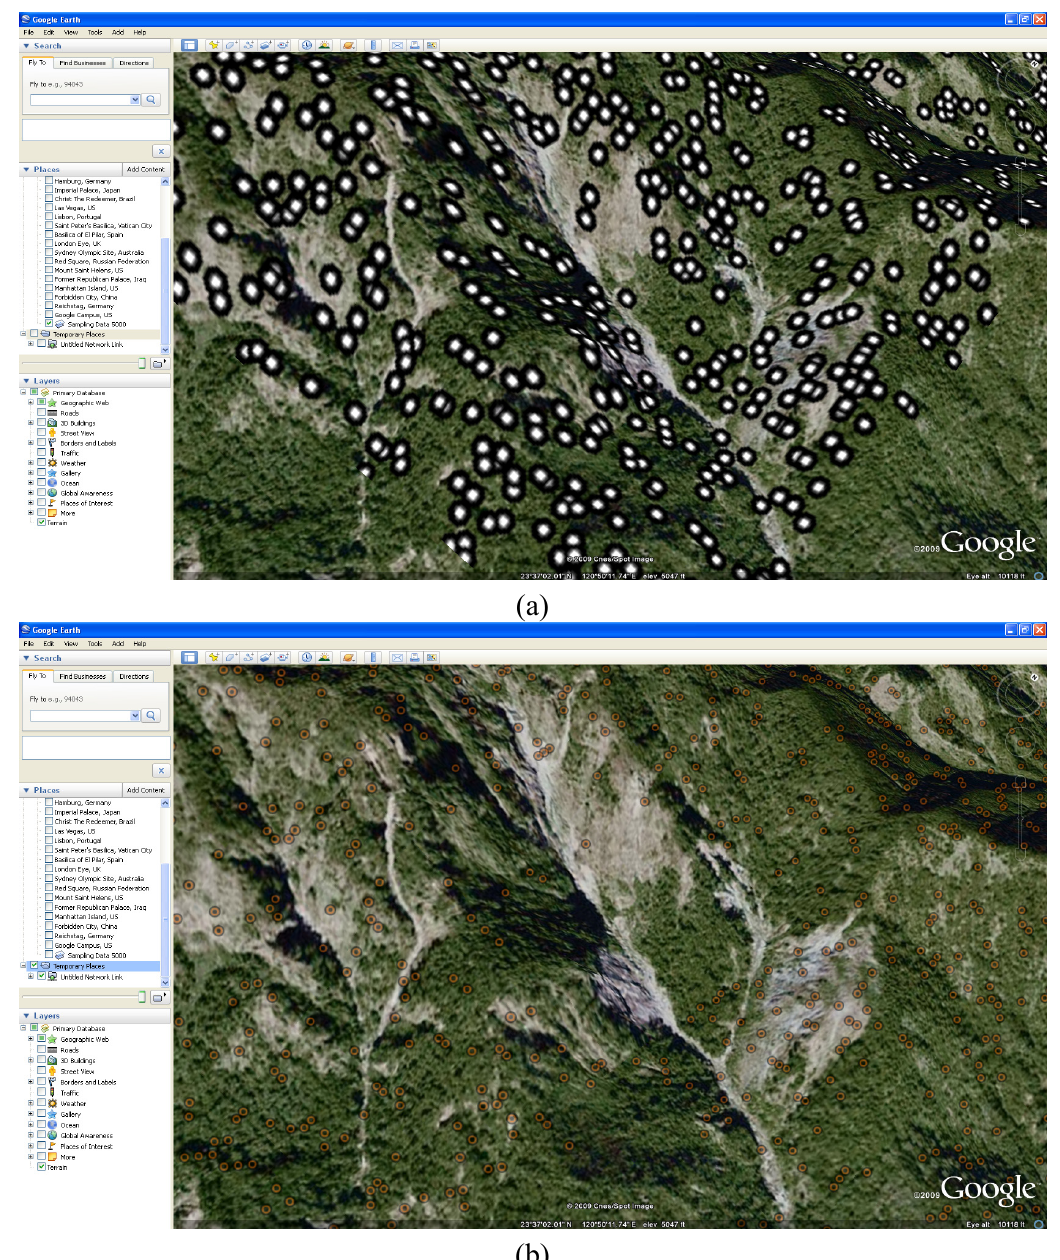
Figure 11. (a) Sampling data is overlaid on the latest image of Google Earth; (b) The server delivered a KML according to end-user's request on Google